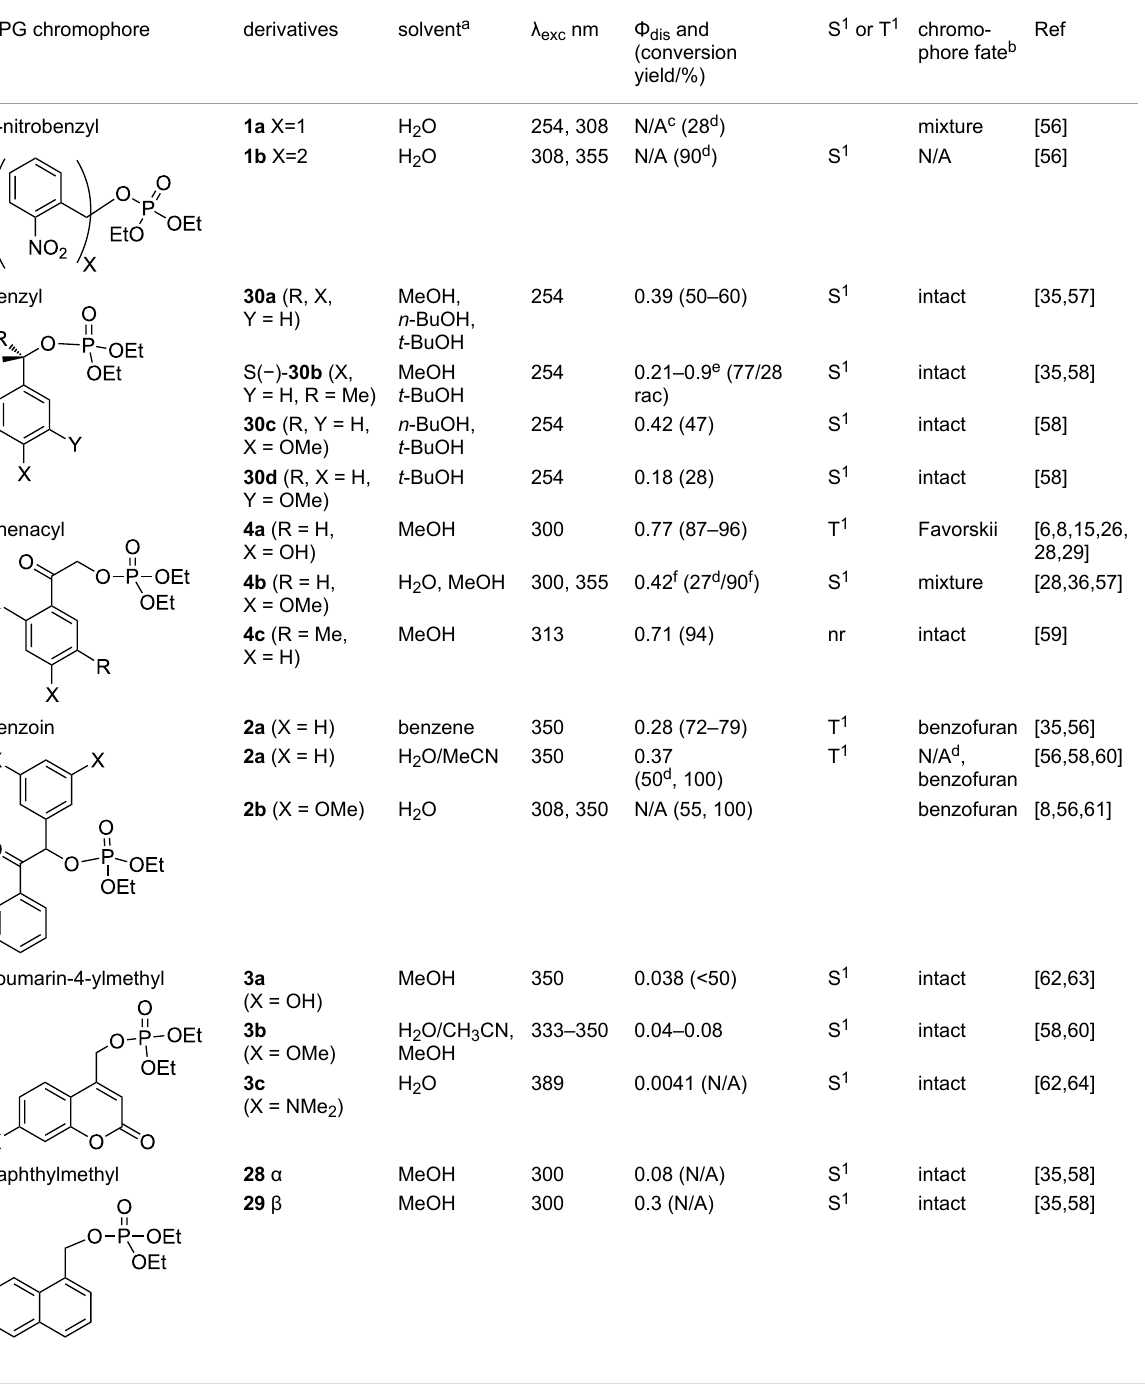
yield (or photochemical efficiency) and the complexity of the photochemical products and byproducts in the photolyzate mix- ture. Solvents and excitation wavelengths are also given in Table 4 as a guide on selecting a PPG using these reaction para- Table 4: A comparison of photorelease from cages for diethyl phosphates. Chemical yields, quantum yields, efficiencies and complexity based on solvents and chromophores. PPG chromophore